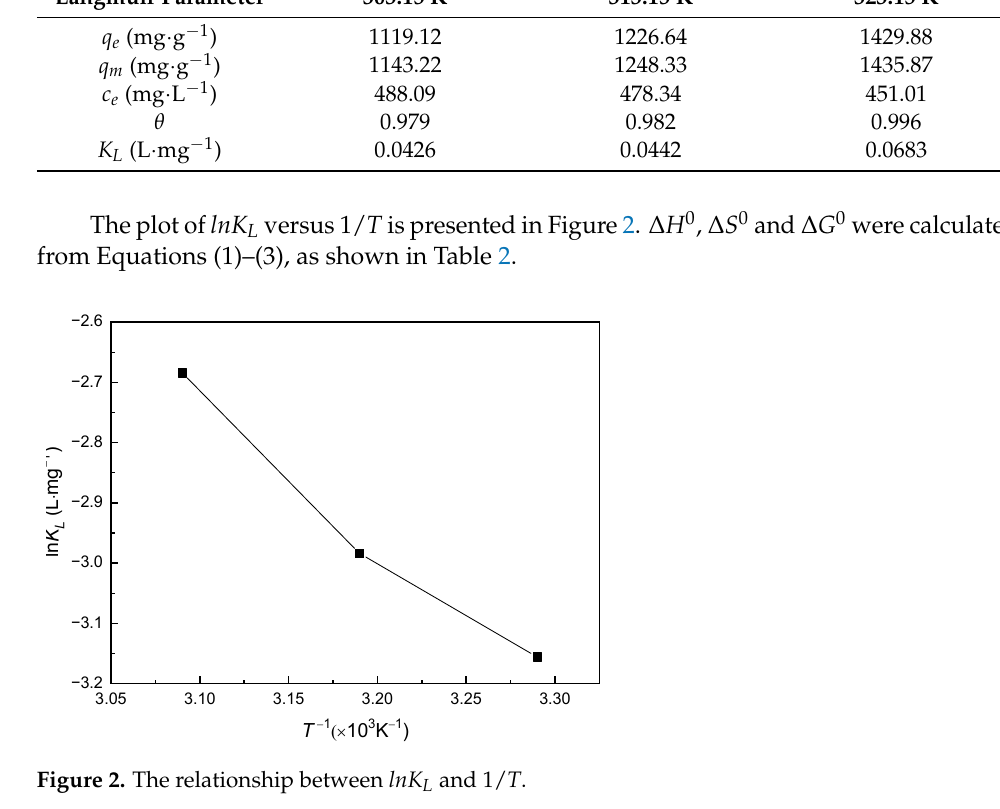
Table 1. Fitting parameters calculated using the Langmuir isotherm model. Langmuir Parameter